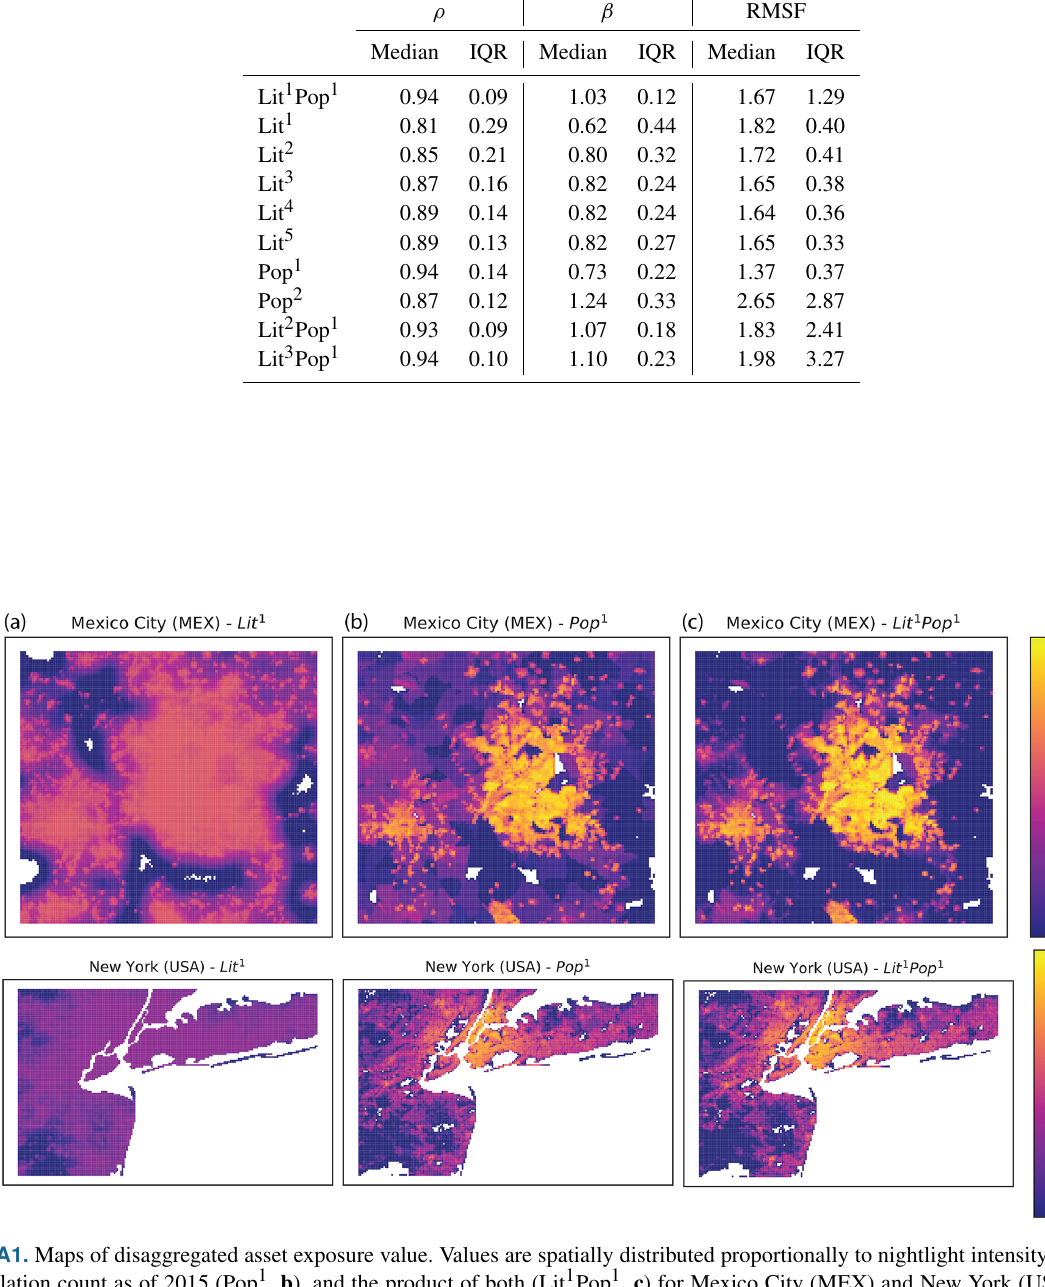
Figure A1. Maps of disaggregated asset exposure value. Values are spatially distributed proportionally to nightlight intensity of 2016 (Lit 1 , a ), population count as of 2015 (Pop 1 , b ), and the product of both (Lit 1 Pop 1 , c ) for Mexico City (MEX) and New York (USA). The maps are restricted to the wider metropolitan areas of Mexico City (18.9–20 ◦ N, 99.8–98.6 ◦ W) and New York (40–41 ◦ N, 74.6–73 ◦ W). The color bar shows asset exposure values in current US dollars in